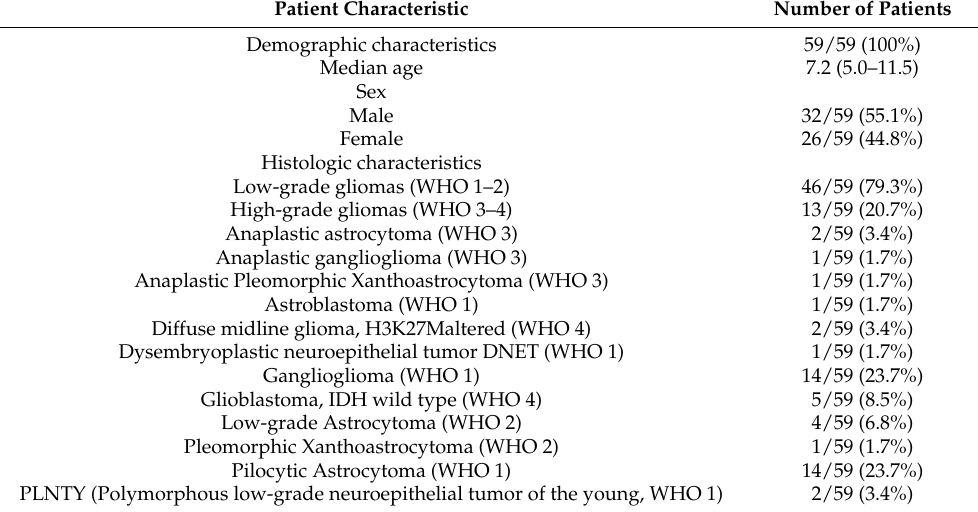
Table 1. Patient demographic, histologic, and molecular characteristics.